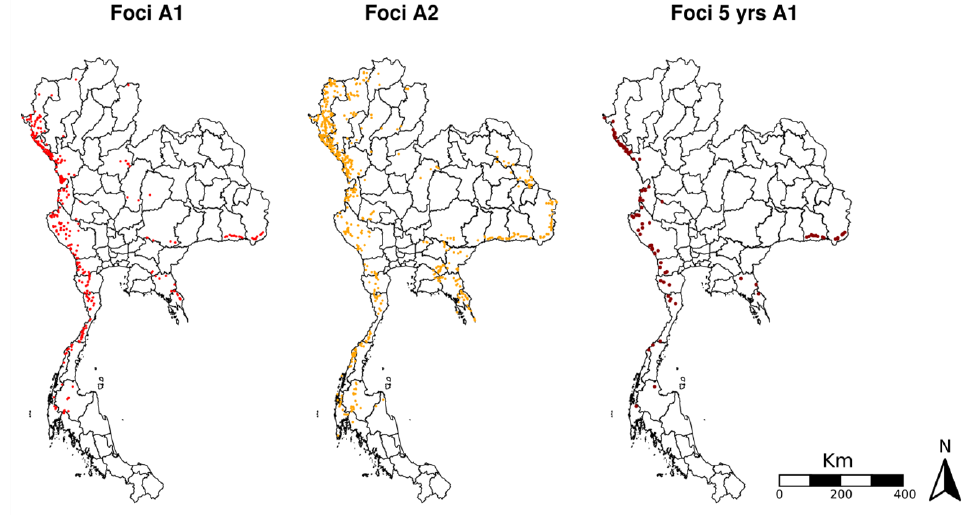
Figure 2. Spatial pattern of A1 and A2 foci and persistent A1 foci (as foci reported as active throughout the time window FY2016 to FY2020).